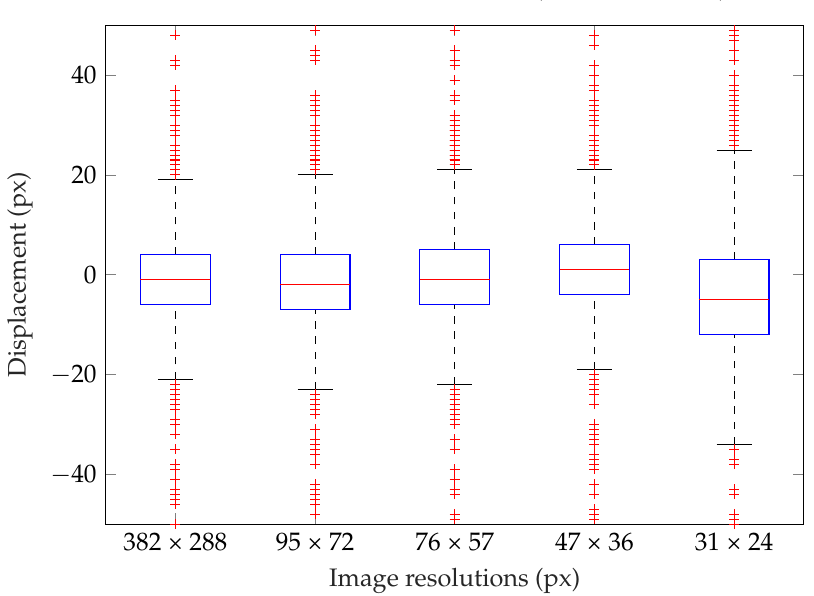
Figure 9. Boxplots showing the difference of reference and detection for X- and Y-coordinate for all tested resolutions. Only in the smallest resolution does the error increase significantly compared to the original